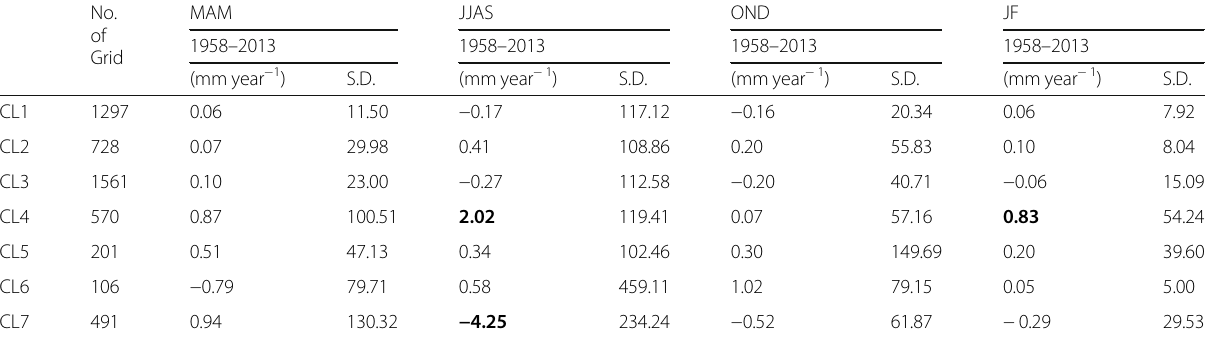
Table 2 Regression coefficient of the long-term trend of seasonal precipitation on each cluster for 1958 – 2013 No.